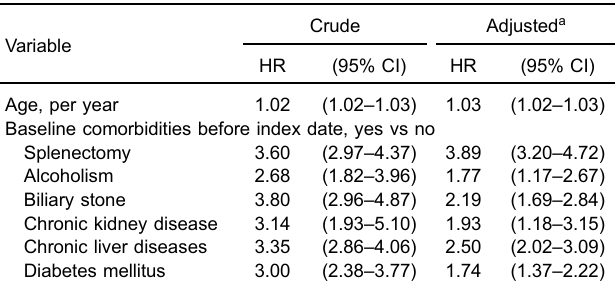
Table 3. Adjusted hazard ratio and 95% con fi dence interval of pyogenic